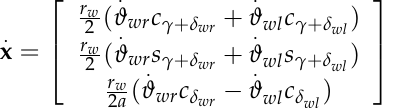
With a critical analysis of Equations (1) and (2), it is possible to define the aforemen- tioned classes of steering configurations, briefly described hereby and illustrated in Table